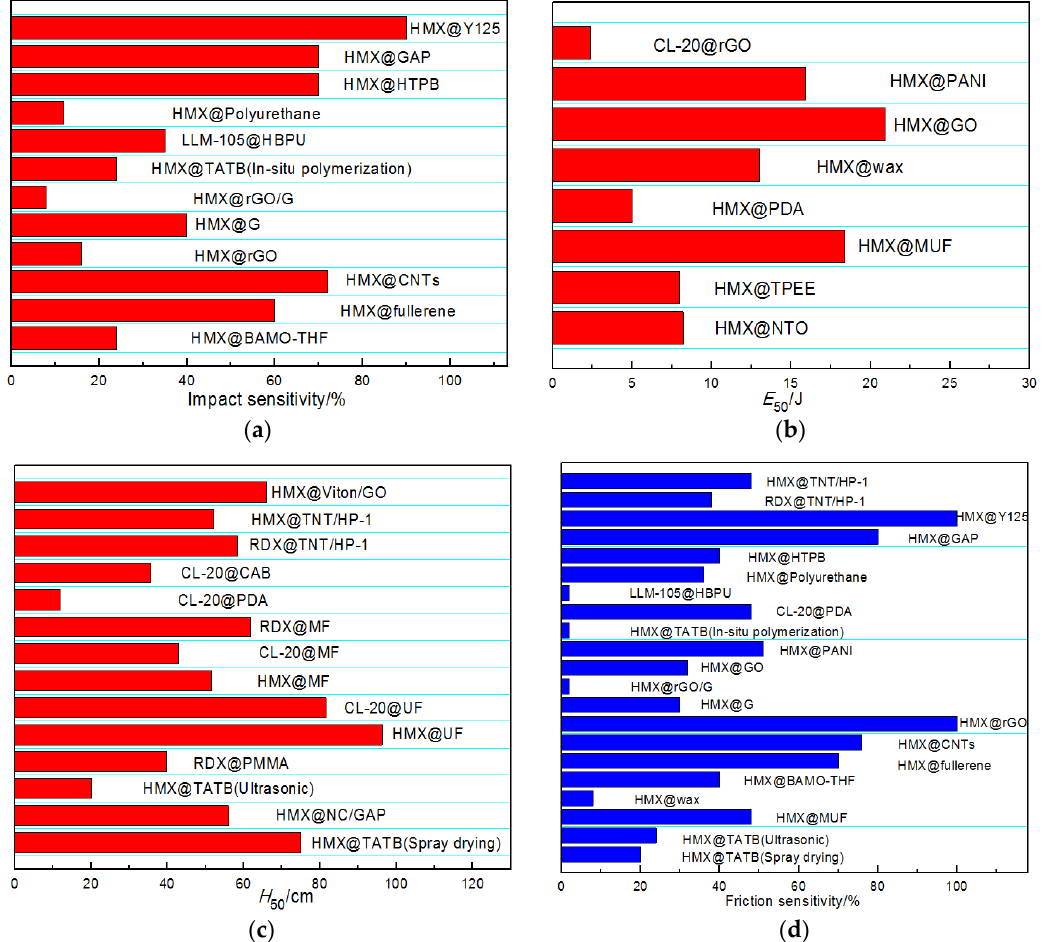
Figure 11. Impact sensitivity and friction sensitivity of some typical CSEs: ( a ) Impact sensitivity denoted by explosion probability according to GJB-772A-97 standard method; ( b ) Impact sensitivity denoted by E 50 according to the Bundesanstalt für Materialprüfung (BAM) method [100]; ( c ) Impact sensitivity denoted by H 50 according to GJB-772A-97 standard method; ( d ) Friction sensitivity. Table 3. Preparation methods and properties improvement of some CSEs.